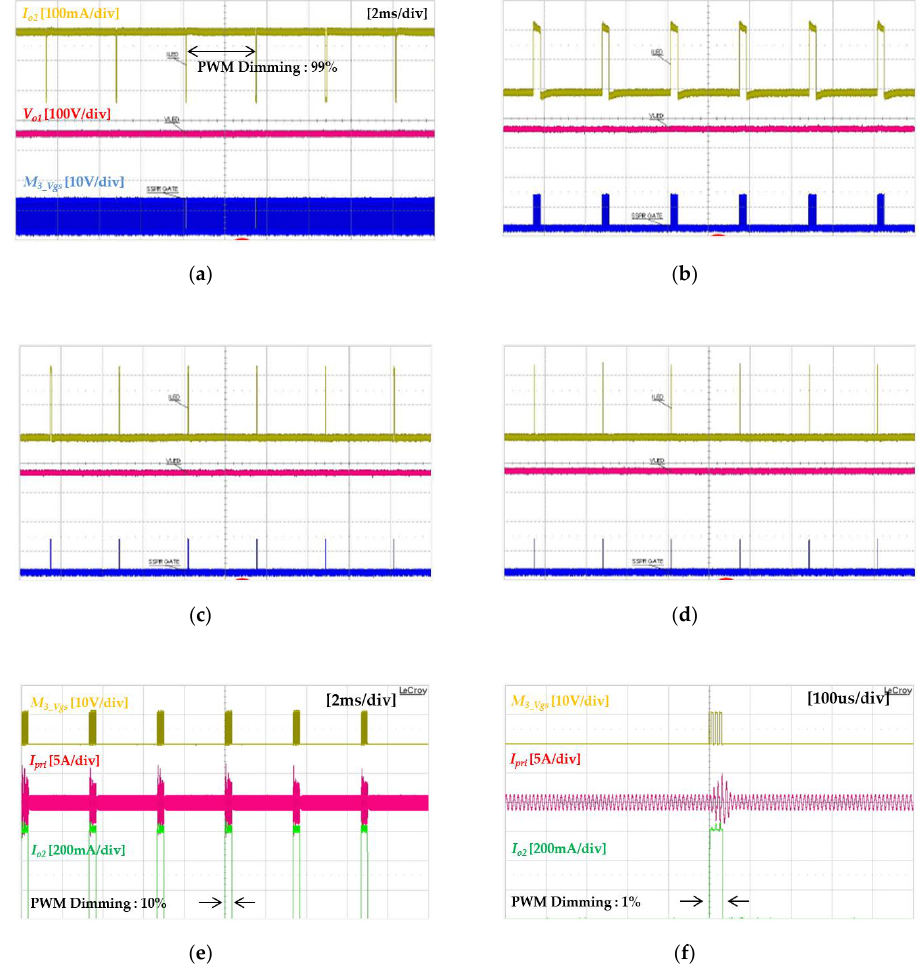
Figure 11. Experimental waveforms according to LED 2D / 3D dimming: ( a ) 2D pulse width modulation (PWM) dimming: 99%; ( b ) 2D PWM dimming: 10%; ( c ) 2D PWM dimming: 1%; ( d ) 2D PWM dimming: 0.2%; ( e ) 3D PWM dimming: 10%; and ( f ) 3D PWM dimming: 1%.